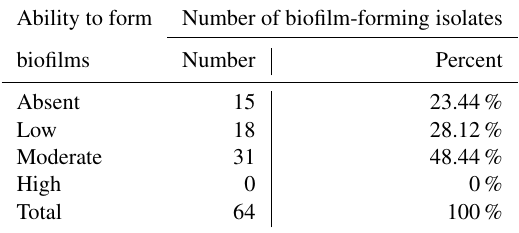
Table 4. Formation of biofilms by S. aureus isolates. Ability to form